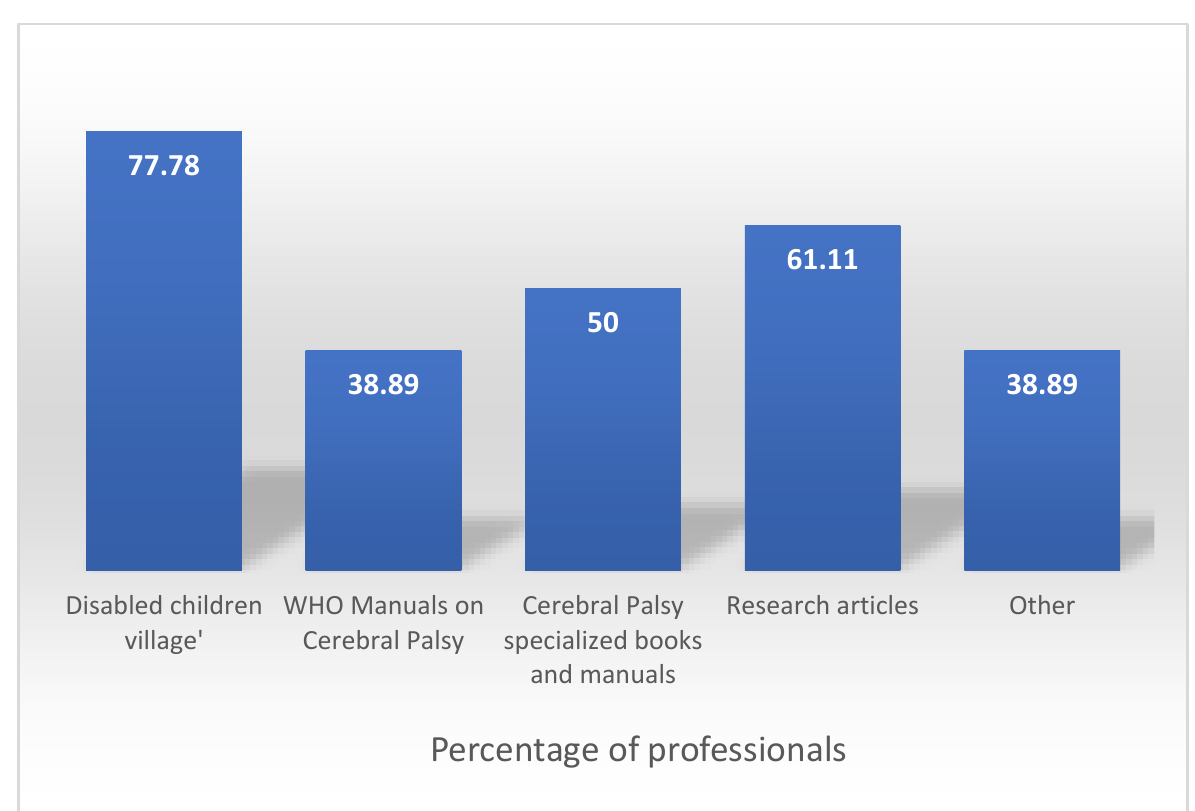
Figure 1. Percentage of professionals using different bibliographic resources.